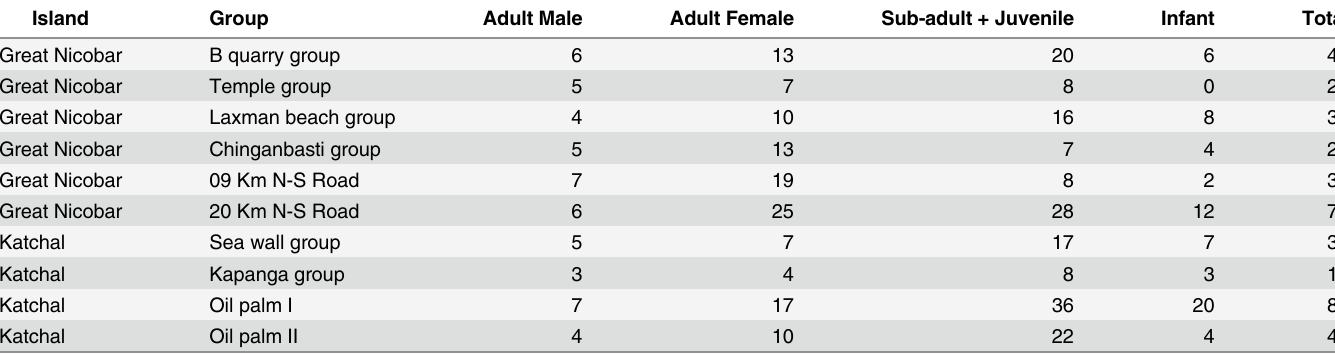
Table 3. Group Size and age-sex composition of M . f . umbrosus groups in Nicobar Islands. Island Group Adult Male Adult Female Infant Total Great Nicobar B quarry